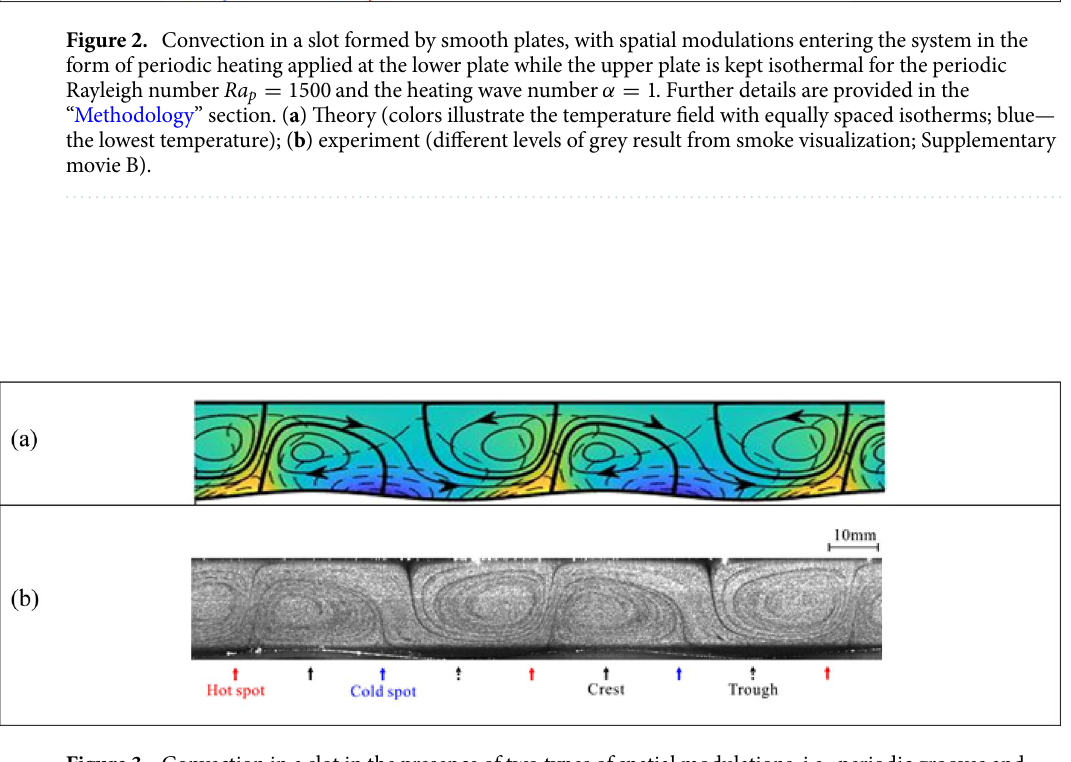
Figure 3. Convection in a slot in the presence of two types of spatial modulations, i.e., periodic grooves and periodic heating. Grooves have amplitude A = 0.1 and heating has amplitude corresponding to the periodic Rayleigh number Ra p = 1500 . Spatial distributions of both stimuli are characterized by the same wave number α = 1 (perfect tuning) and their relative position is described by the phase difference � = π/ 2 . Further details are provided in the “Methodology” section. ( a ) Theory (colors illustrate temperature field with equally spaced isotherms; blue—the lowest temperature); ( b ) experiment (different levels of grey result from smoke visualization; see Supplementary movie